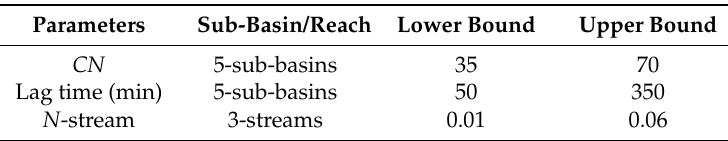
Table 2. Parameter optimizations in the HMS